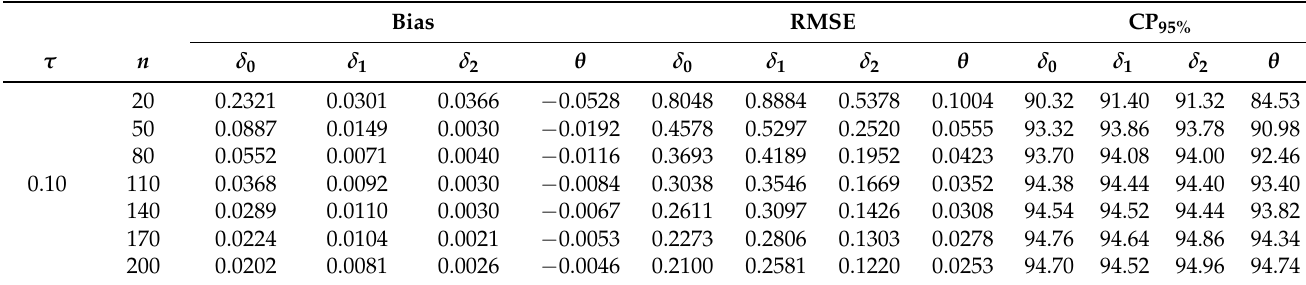
Table 5. Empirical bias, RMSE, and 95% CP (true values: δ 0 = 1.00, δ 1 = 1.00, δ 2 = 0.50, and θ = 0.50) with simulated